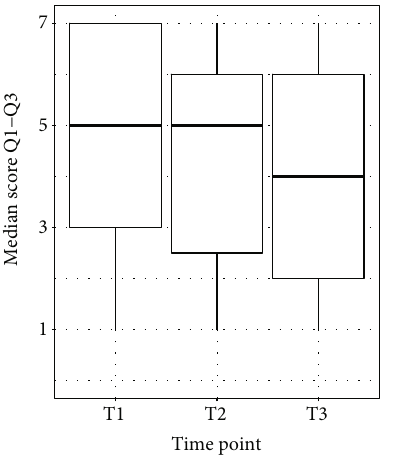
Figure 4: The median scores of the rubber hand illusion questionnaire reached for questions Q1-Q3 for time point 1 (T1), time point 2 (T2), and time point 3 (T3).